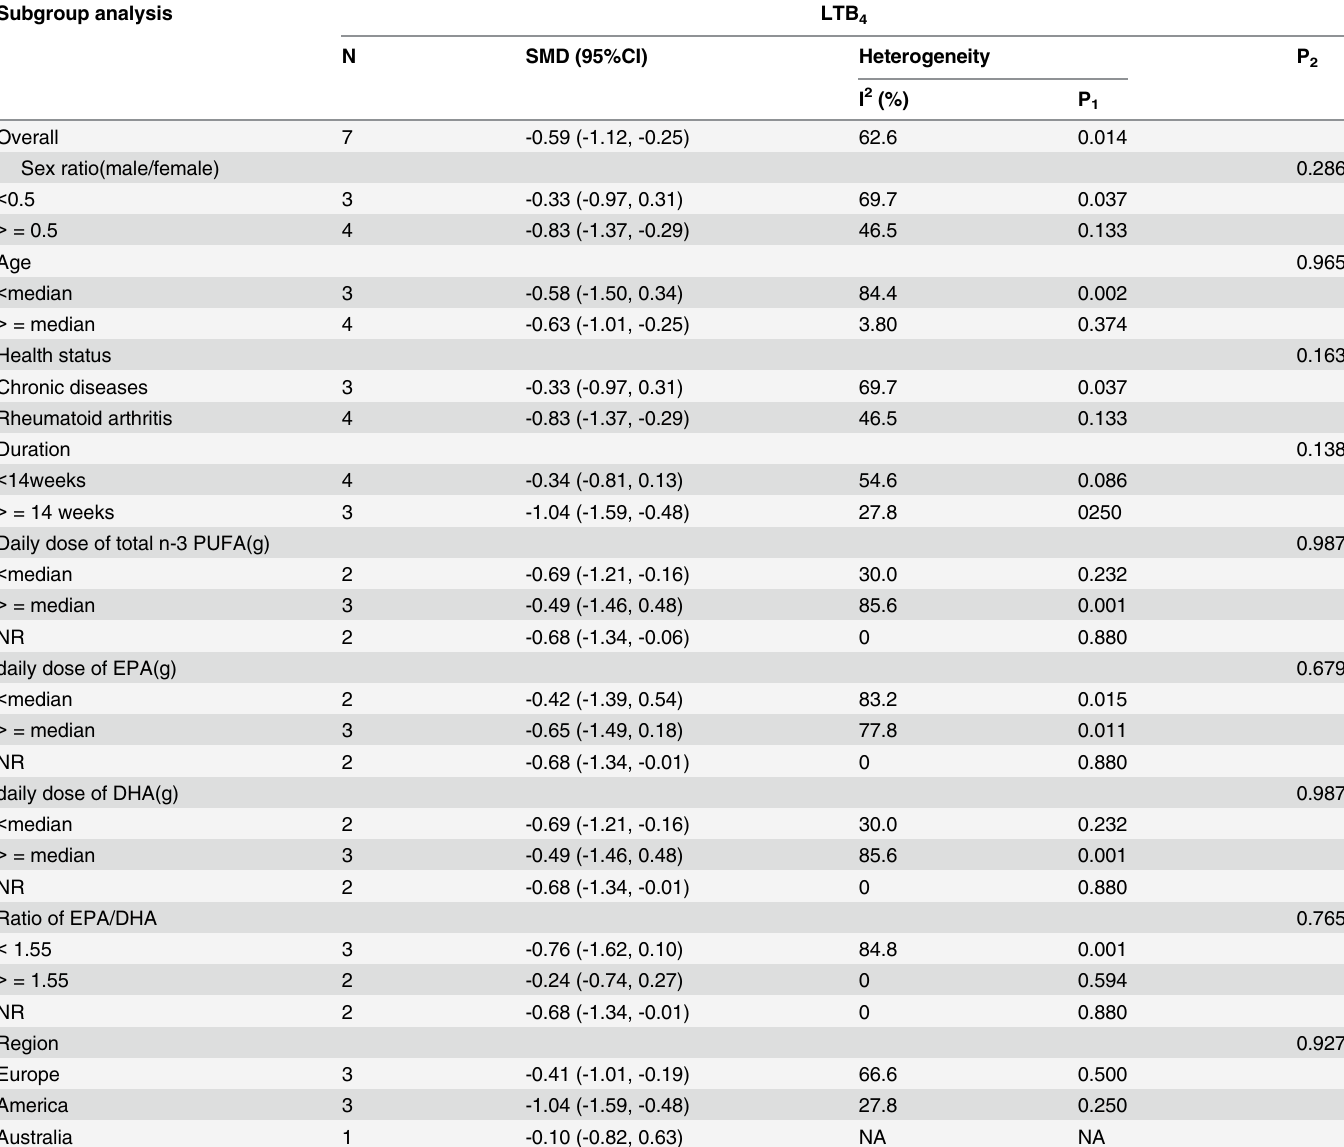
Table 2. Subgroup analysis for the effect of marine-derived n-3 PUFAs on LTB 4 in unhealthy subjects (subjects with non-autoimmune chronic dis- eases or auto-immune diseases). Subgroup